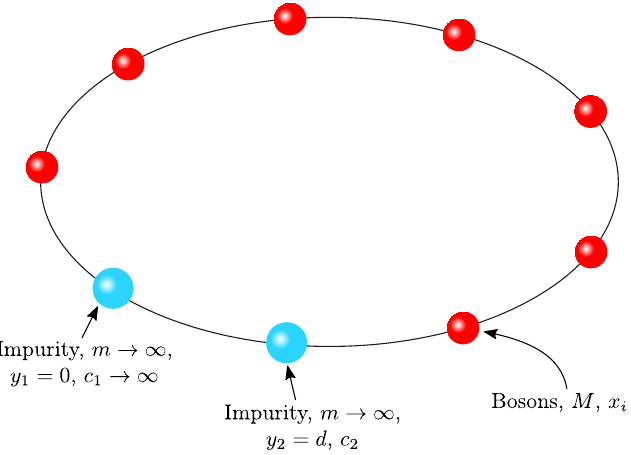
. One impenetrable impurity i